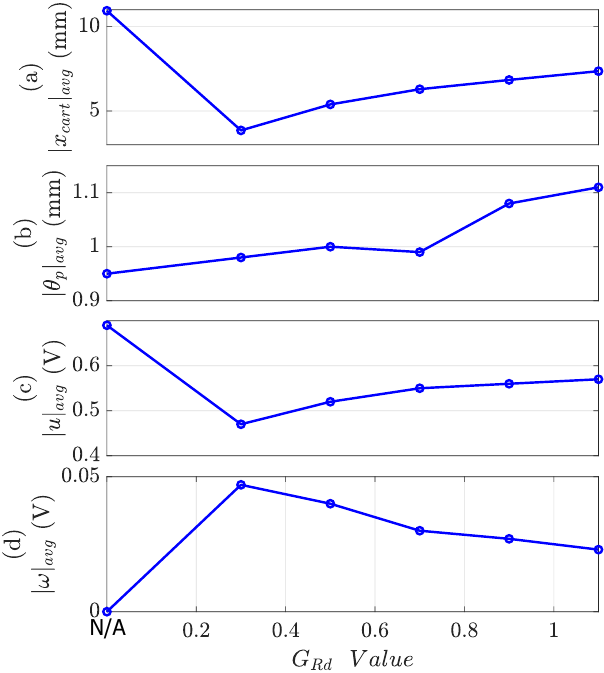
Figure 12. LQR d tuning data